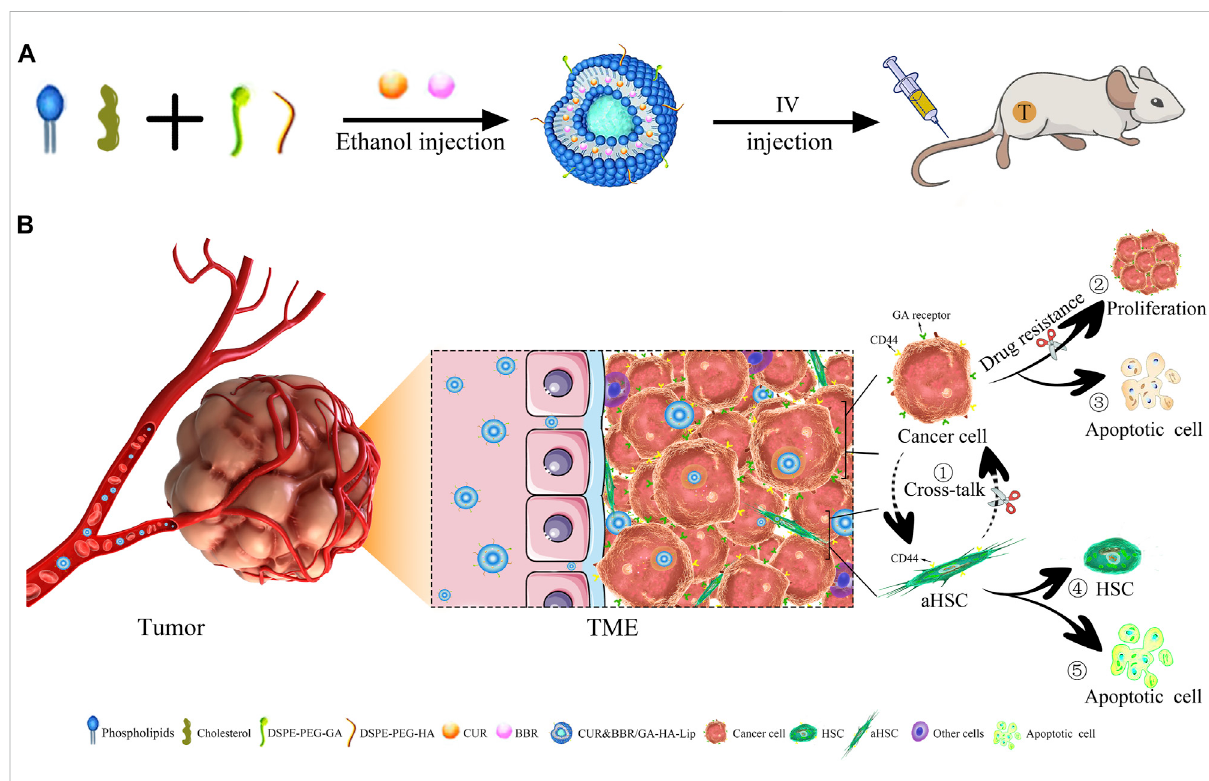
| Anti-tumor schematic diagram of CUR&BBR/GA-HA-Lip. (A) The preparation and drug administration of the liposomes. (B) The anti-tumor activities of the combined therapy of CUR and BBR. ① Blocking the cross-talk between aHSCs and tumor cells, ② – ③ inhibiting proliferation and inducing apoptosis of tumor cells, and ④ – ⑤ inhibiting the activation of